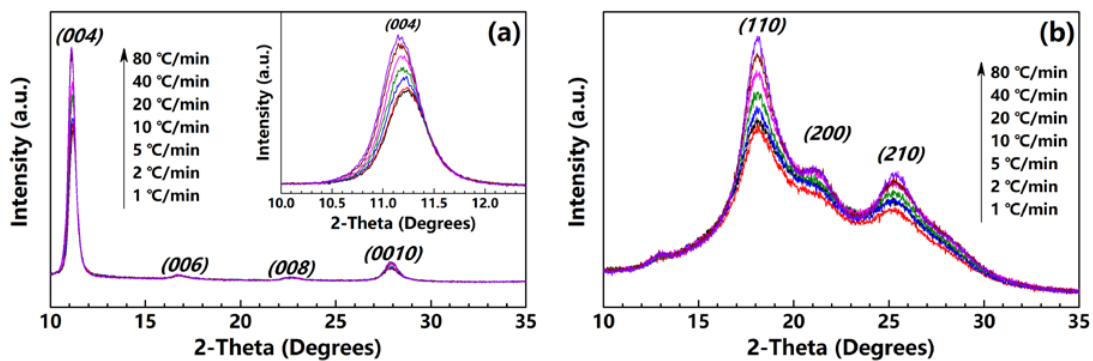
Figure 5. XRD patterns along the ( a ) meridian and ( b ) equatorial directions of fibers obtained at 400 °C under different heating rates.